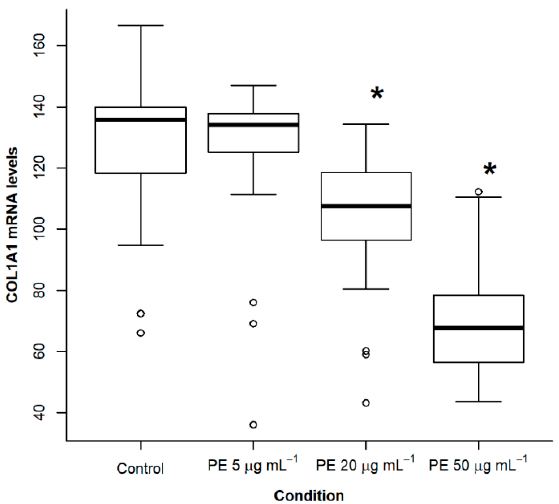
Figure 2 . Effect of different concentrations of phosphatidylethanolamine (PE) on collagen expression in normal human lung fibroblasts. Cells from passages 5–10 were placed in 6 well plates and when confluence was reached, culture medium was substituted with serum-free medium for 24 h. PE was diluted in F-12 without serum at 5, 20 and 50 µg·mL − 1 and cells were incubated for 48 h. Controls were grown for the same time in F-12 without serum. The figure represents the pooled data of three independent experiments. Asterisks denote significant differences ( p < 0.05, ANOVA with post-hoc Dunnett test against the control).